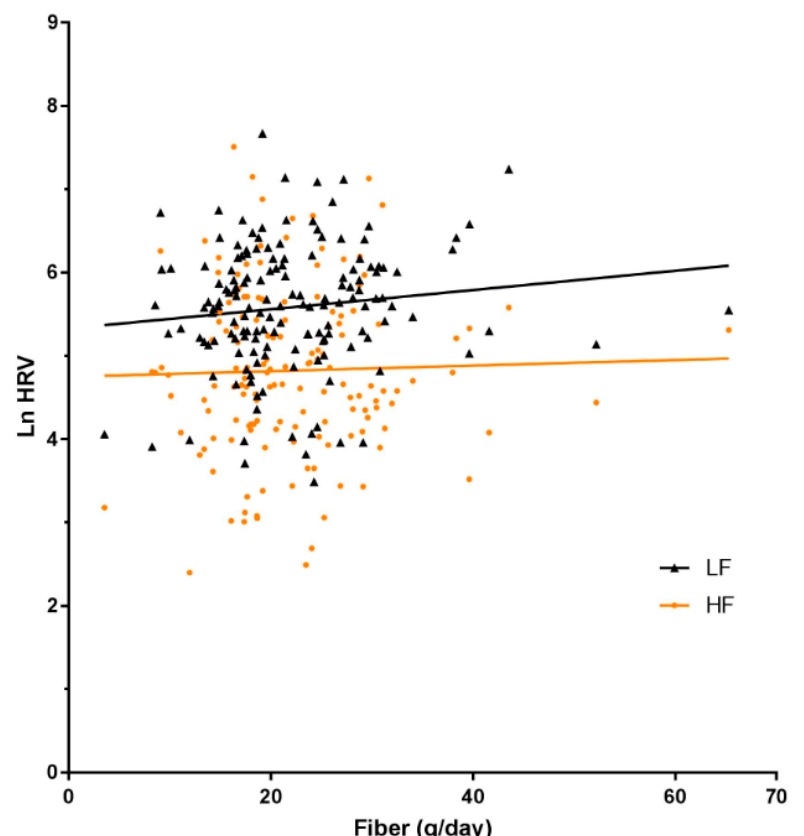
Figure 1. Correlation between maternal fibre (g/day) intake for the duration of pregnancy and newborn autonomic function (HRV).